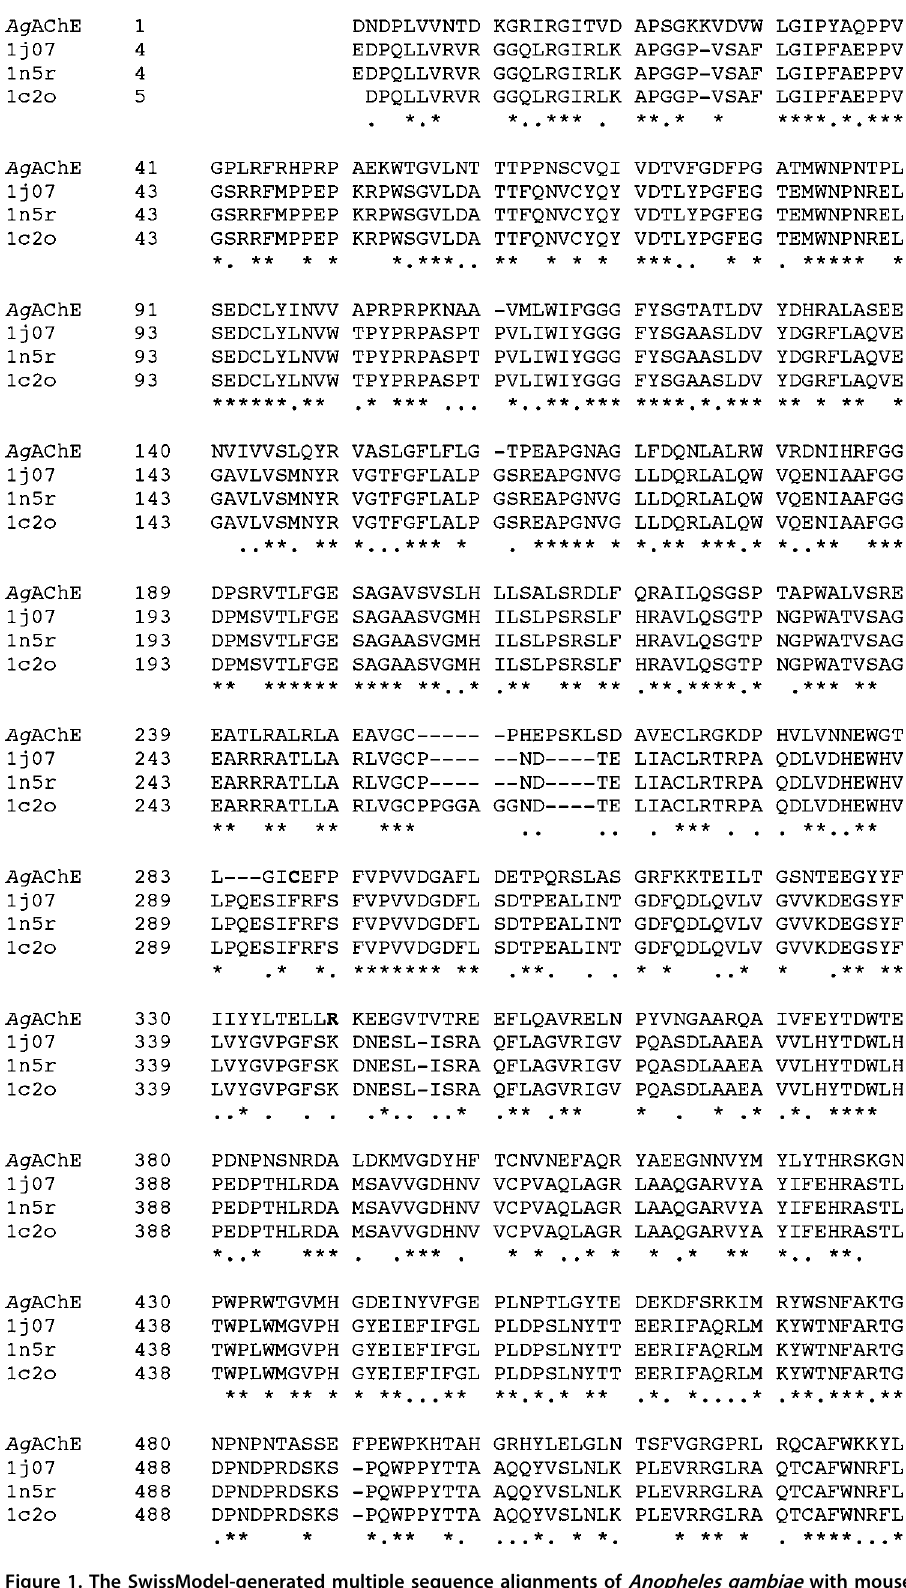
PLoS ONE | www.plosone.org